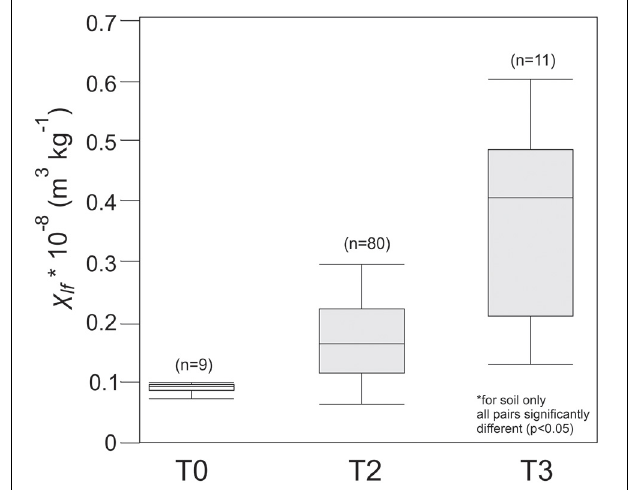
FIGURE 5 | Quantile box plot of X lf by terrace for the Delaware River Valley study area. The horizontal quantile lines represent, from bottom to top, the minimum, 10, 25%, median, 75, 90%, and maximum. The X lf values are for soil only, no C, transitional C, or lamellae horizons were included in this analysis. An ANOVA and Tukey test show that the means are significantly different between the three groups ( p < 0 . 05).